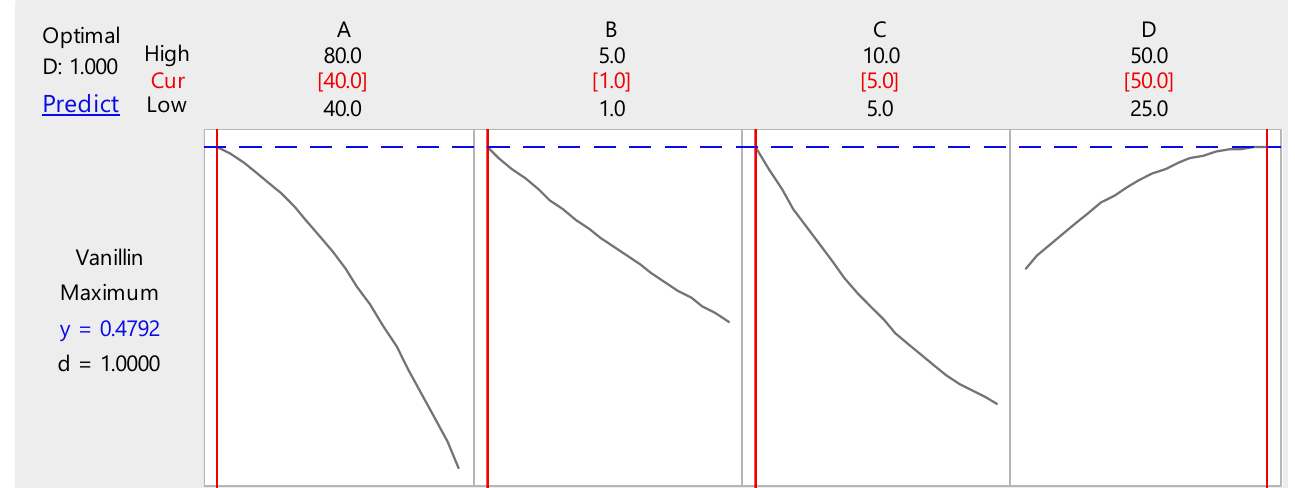
Figure 4. Desirability chart for biovanillin production using Punica granatum peels through solid-